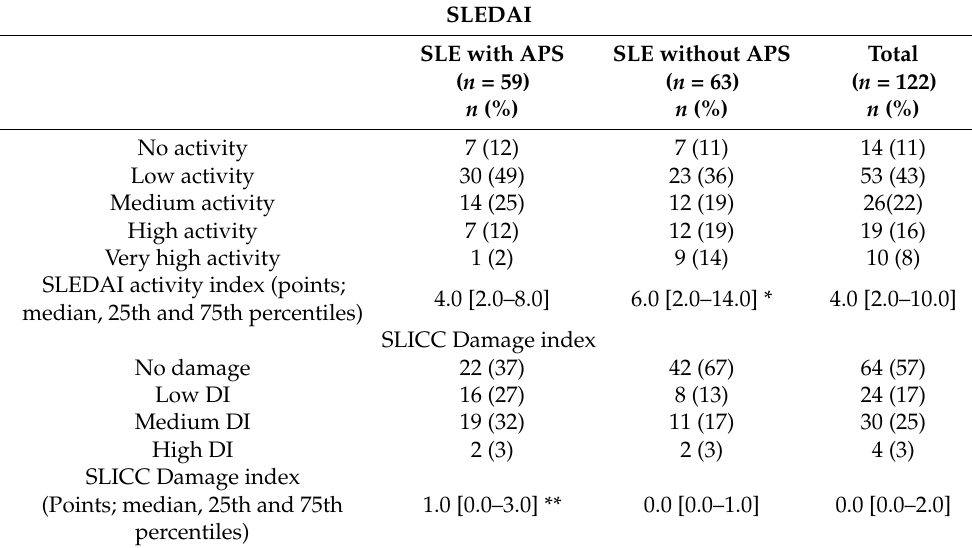
Table 5. Assessment of activity and organ damage in patients with systemic lupus erythematosus at the time of study